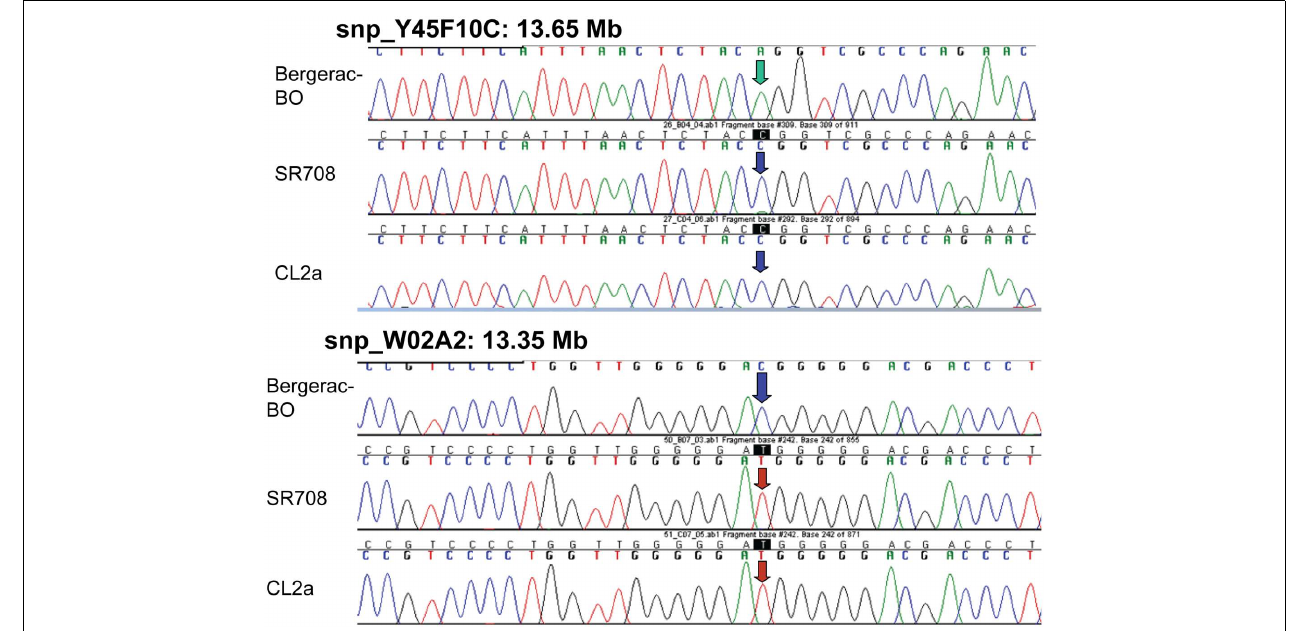
lsq4 -congenic strain SR708. At the two indicated SNPs,Y45F10C at 13.65Mb andWO2A2 at 13.35Mb, SR708 has the CL2a genotype, indicating that the introgressed BO-like segment of SR708 must lie within that interval.